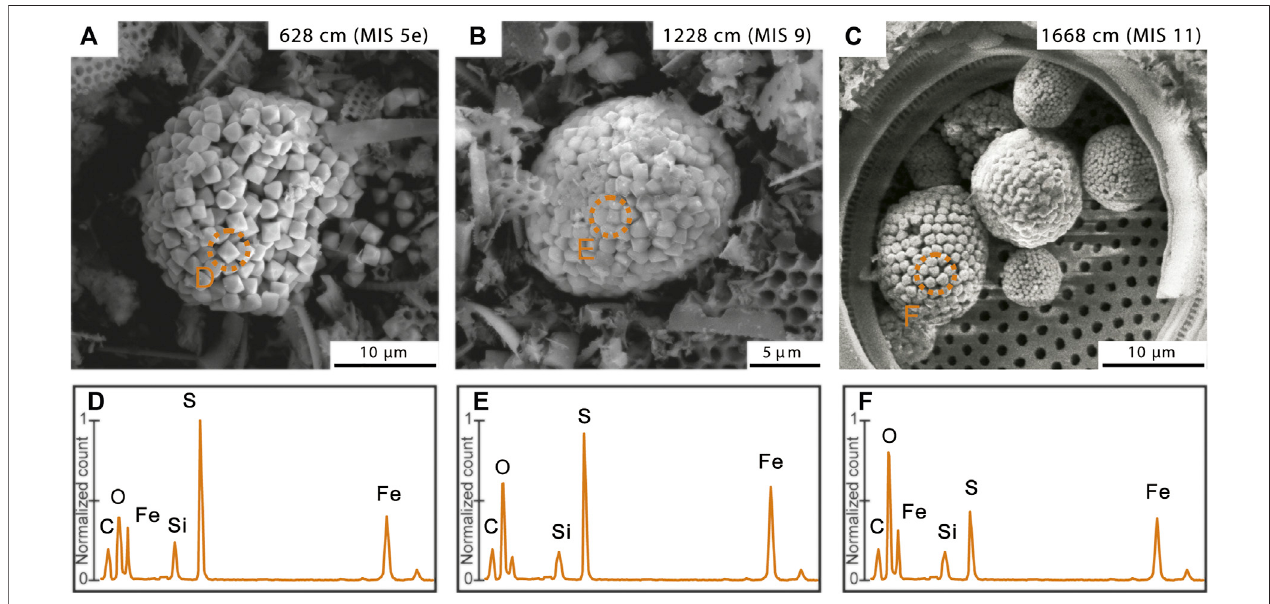
FIGURE6 | Scanning Electron Microscope (SEM) images and related Energy-Dispersive X-ray Spectroscopy (EDS) analysesof three interglacial samplesat depth of 628 cm (MIS 5e) (A – D) , 1128 cm (MIS 9) (B – E) , and 1668 cm (MIS 11) (C – F) . Each sample contains various-sized framboidal pyrites within the diatom frustules.